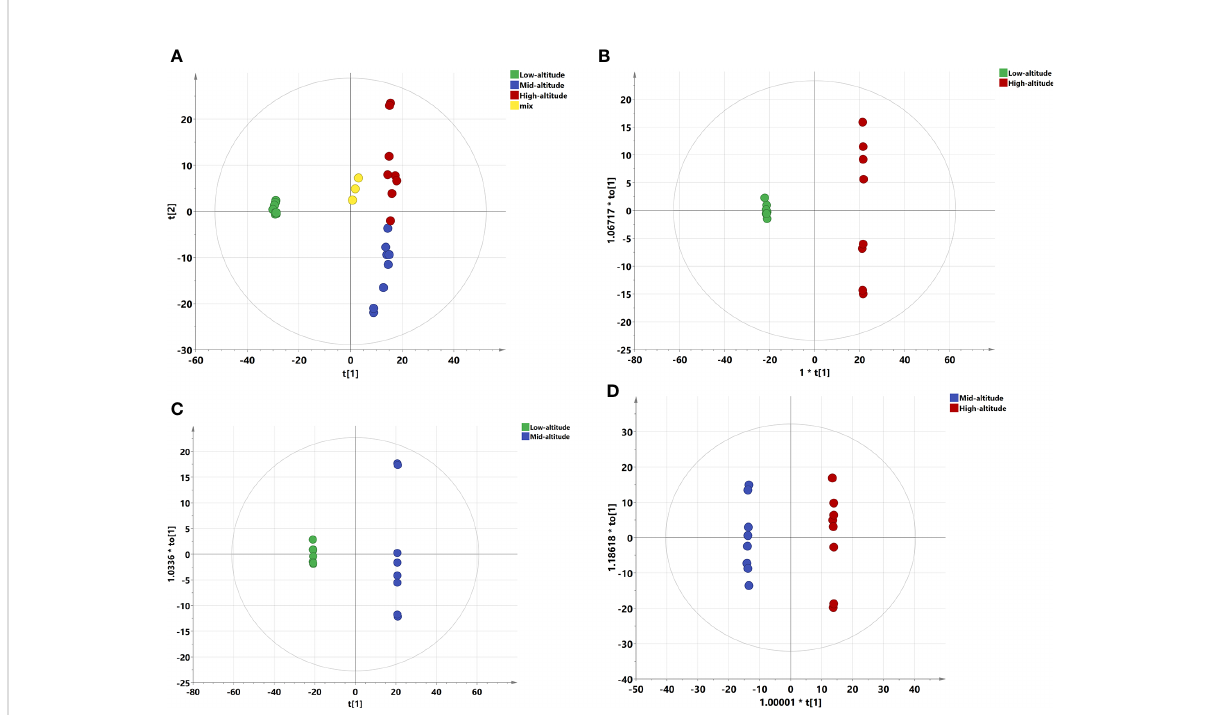
FIGURE 1 PCA and OPLS-DA scoring charts of Draba oreades Schrenk at different altitudes. (A) PCA plot. (B) OPLS-DA model score at Low-altitude vs High- altitude. (C) OPLS-DA model score at Low-altitude vs Mid-altitude. (D) OPLS-DA model score at Mid-altitude vs High-altitude. QC, quality